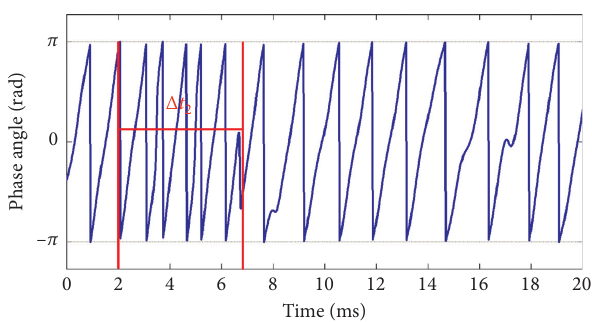
Figure 15: Time-phase angle curve with the frequency of